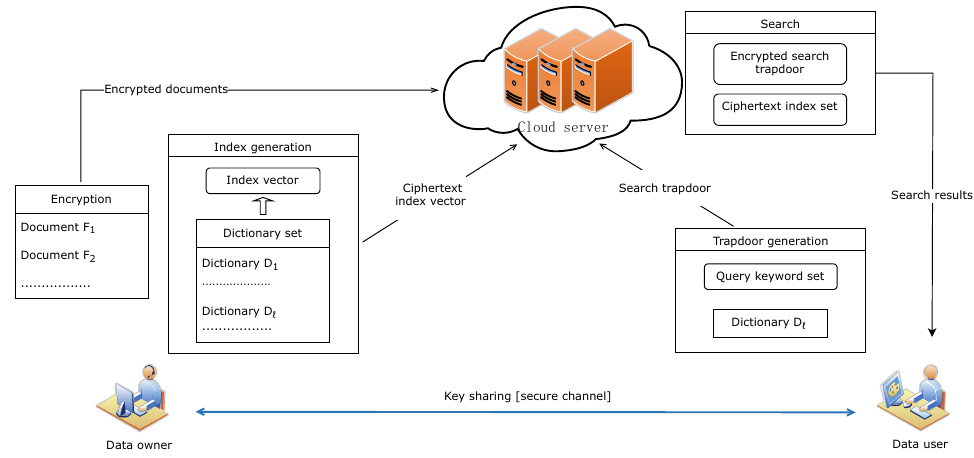
Figure 1. System